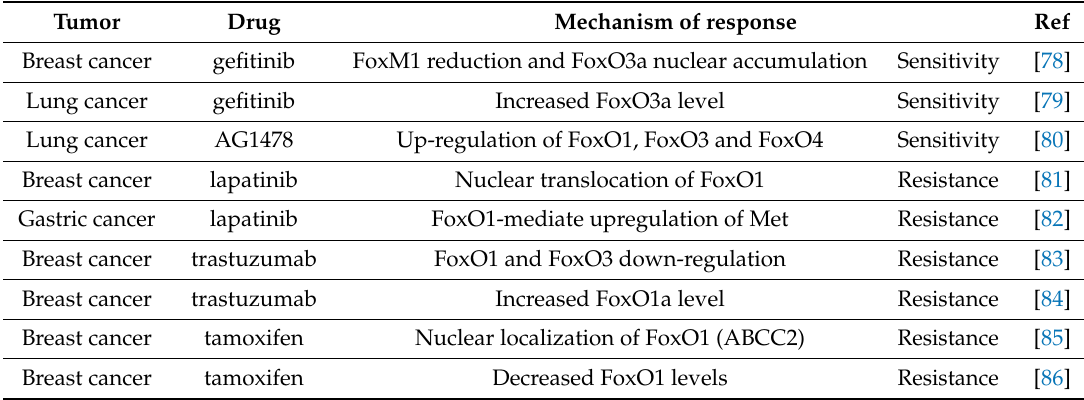
Table 2. FoxO role in cell response to target specific